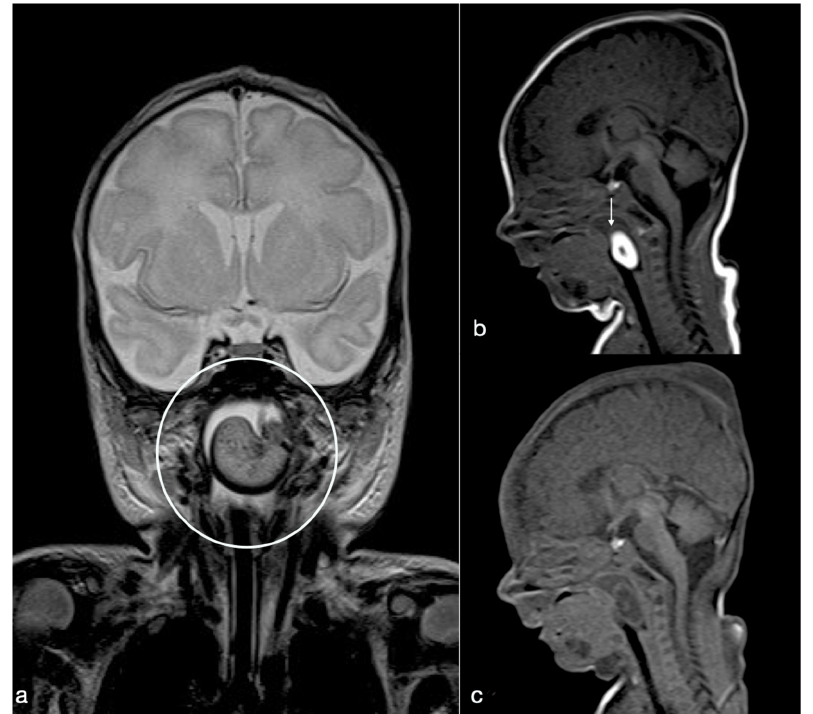
Figure 1. We report the case of respiratory failure in a male newborn, whose pregnancy was unknown until the third trimester when it was discovered due to polyhydramnios. At 38th gestational week, caesarean section was needed due to fetal suffering: he was born pale, floppy, hypotonic, not reagent to external stimuli, with a low heart rate (HR (heart rate) < 60 bpm), not responsive to medical treatment, and showing increasing oxygen desaturation up to respiratory distress. The intubation was challenging, so physicians performed a fiber-optically controlled one, demonstrating a well-defined obstructive nasal-oropharyngeal soft white mass. After vital parameters stabilization, he was immediately transferred to the neonatal intensive care. On physical examination, no abnormalities were noticed; also, cardiac, pulmonary, and abdominal examinations were normal. He promptly underwent magnetic resonance imaging (MRI) investigation to define the lesion. MRI of head and neck revealed a well-defined soft tissue pedunculated mass (2.5 × 2 × 1 cm), arising from the left nasal-oropharynx wall, occupying the space between the epiglottis and the uvula in the midline. In the T2-weighted coronal section ( a ), it appears hyperintense with small punctate hypointense foci in the center and hypointense peripherally (open circle). A T1-weighted image obtained on the sagittal plane ( b ) shows a hyperintense “pearly” appearance of the lesion (arrow), with the exception of a small hypointense center. In the unenhanced, fat-saturated sagittal T1-weighted image ( c ), the mass is completely hypointense, consistent with a fat-rich content. These findings were consistent with oropharyngeal dermoid polyp (DP); in particular, a DP does not show restricted diffusion, contrary to an epidermoid cyst [1]. DPs have to be differentiated by other lesions within the region of the skull base or pharynx, which may cause children’s respiratory distress, such as meningoencephalocele, neuroglial heterotopias, and gliomas [1–3]. In particular, a DP differs from a meningoencephalocele, which is hypointense on T1-weighted and FLAIR images (similar to brain tissue), showing a direct communication through a skull base defect with the cranial vault; or from neuroglial heterotopy, which shows T1 and T2 signal characteristics of brain gray and white matter with small enclosed cysts; instead of gliomas, which usually show a hypointense signal on T1-weighted images [1]. Even if the use of ultrasound is useful for the first-line investigation of neck masses in neonates [4], considering